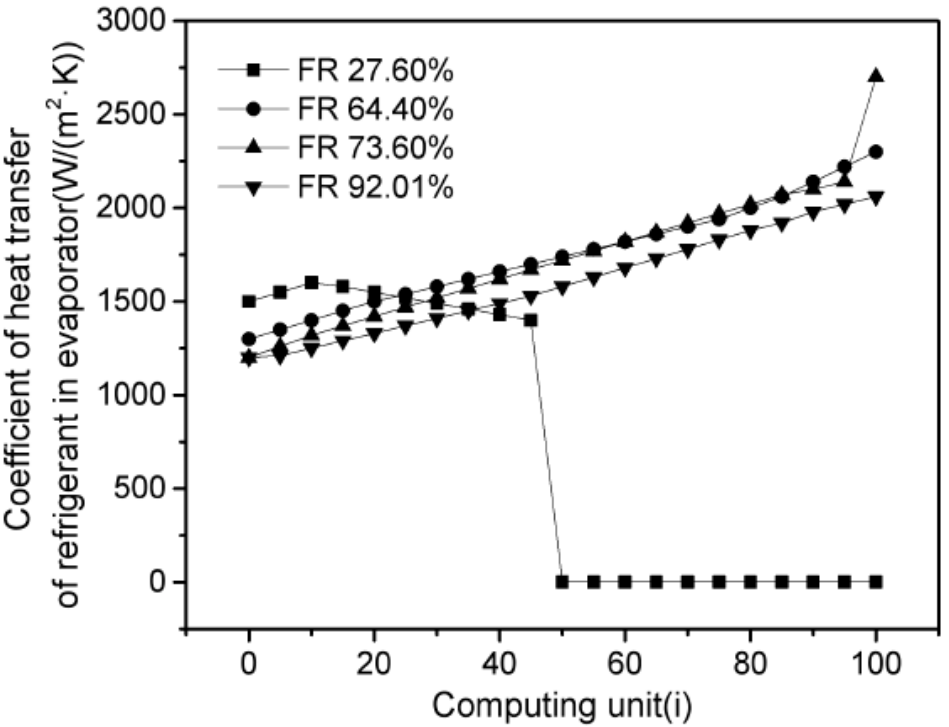
Figure 11. Schematic diagram of refrigerant heat transfer coefficient distribution along the calculation unit in the evaporator.